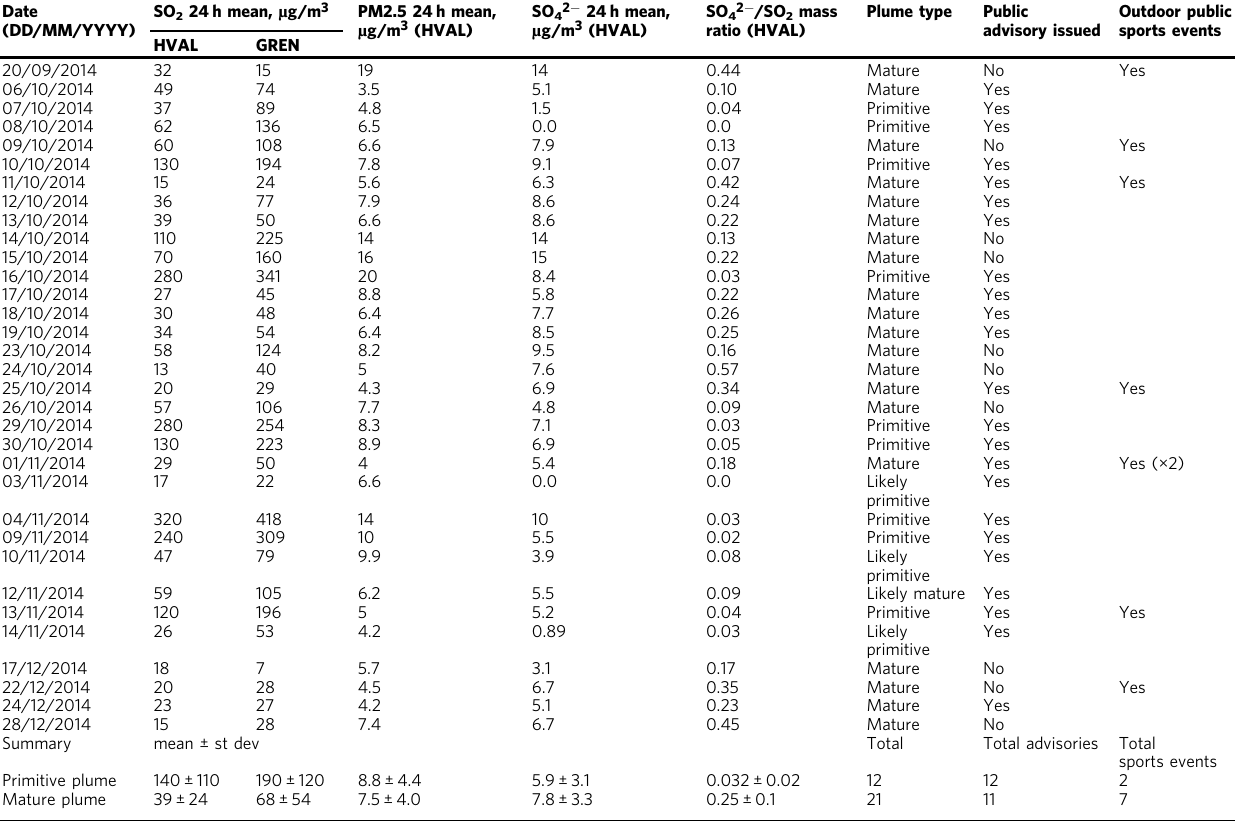
Table 1 Daily-mean (24 h) ground-level concentrations of sulphur dioxide gas (SO 2 , measured at Hvaleyrarholt — HVAL, and Grensásvegur — GREN, EAI stations in Reykjavík) and sulphate aerosol (SO 4 2 − , measured at HVAL only) during the eruption study period (31 August – 31 December